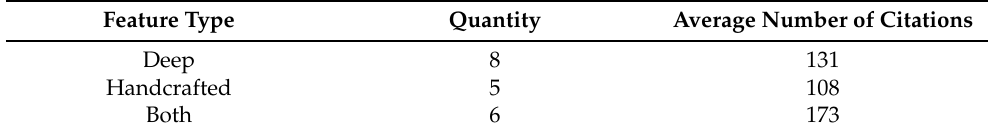
Table 8. Feature extraction.